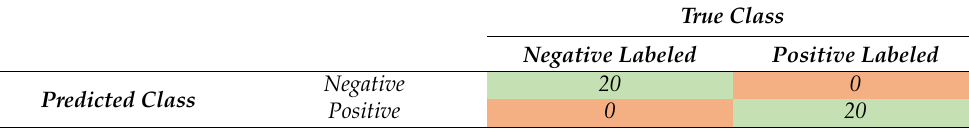
Table 8. Confusion matrix of the 1D CNN classifier in identifying febrile